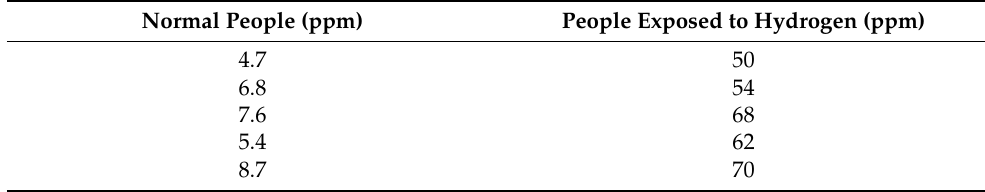
Table 9. Hydrogen levels for the experimental